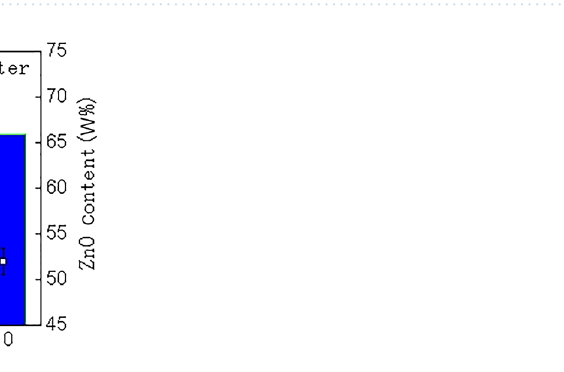
Figure 3. ZnO/WG nanospheres prepared by different concentrations of WG [WG concentrations while preparation: ( a ) 2 mg/mL; ( b ) 4 mg/mL; ( c ) 6 mg/mL; ( d ) 8 mg/mL; ( e ) 10 mg/mL].